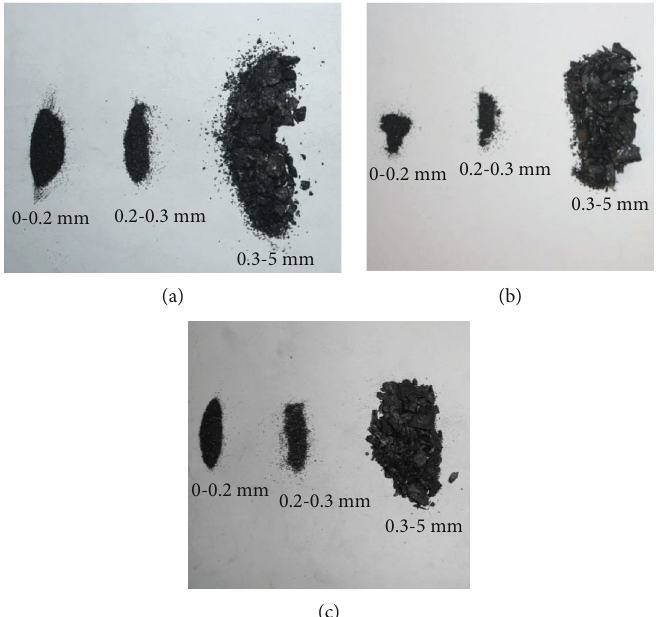
Figure 8: Size statistics of fragments of coal with di ff erent bedding angles under the impact loading. From (a) to (c), the bedding angle is 0 ° , 45 ° , and 90 ° ,